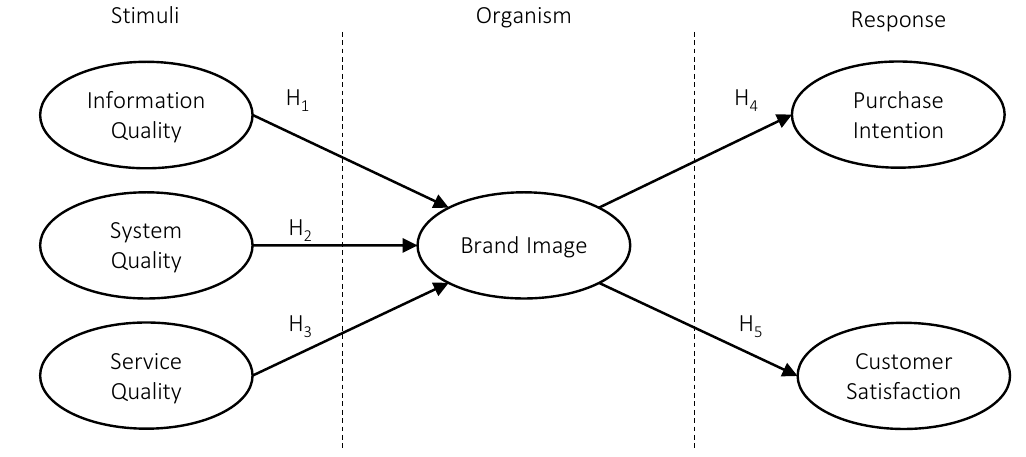
Figure 1. Proposed research